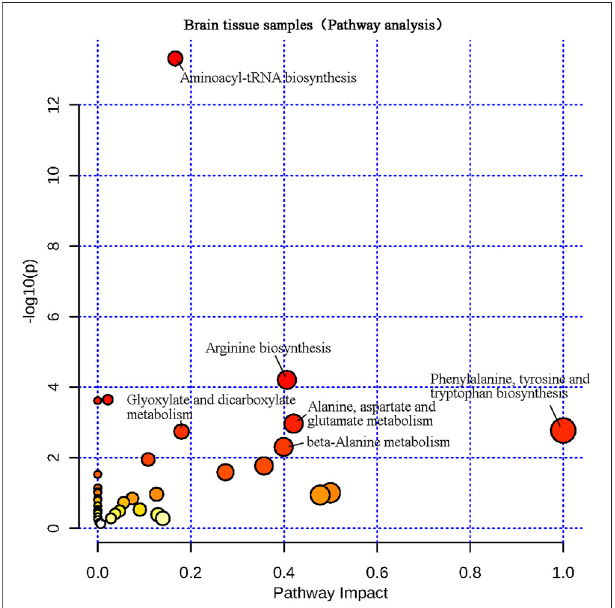
FIGURE 8 | Metabolic pathway analysis of brain tissue